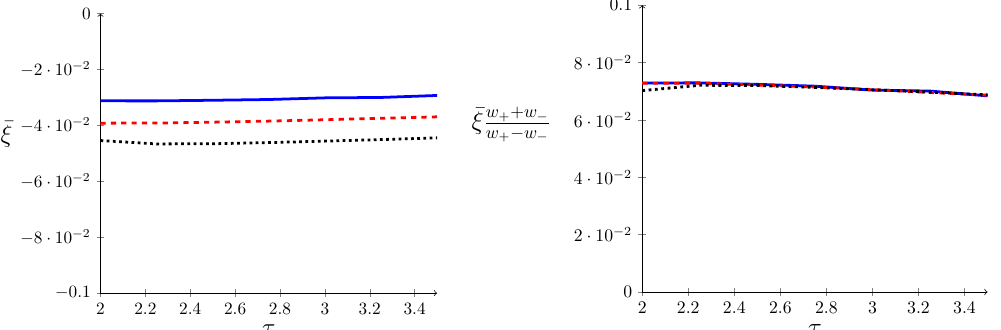
Figure 6 . Left: the rapidity shift (cid:22) (cid:24) ( w function of proper time (cid:28) , for asymmetric collisions with shock widths ( w (dashed red line), ( w black line). Right: the coe(cid:14)cient function (cid:4)( (cid:28) ) (cid:17) (cid:22) (cid:24) ( w Our results for the rapidity shift (cid:22) (cid:24) ( w